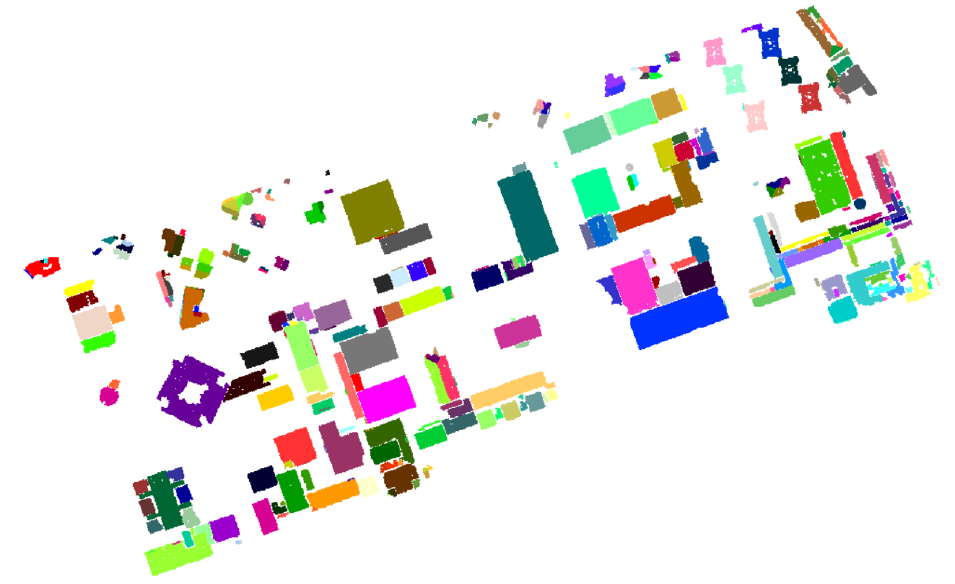
Figure 24. The segments representing the roofs planes with the high greater than 2 m. Next, points belonging to buildings’ facades have been automatically extracted by thresholding the “normalZ” attribute. The points of “building” class are colored based on “normalZ” attribute values (Figure 25), the yellow color showing values in range of 0.9 to 1, the blue color values close to 0 and orange color values in range of 0.8 to 0.9. All points having a value of “normalZ” attribute less than 0.9 have been extracted and are the subject of